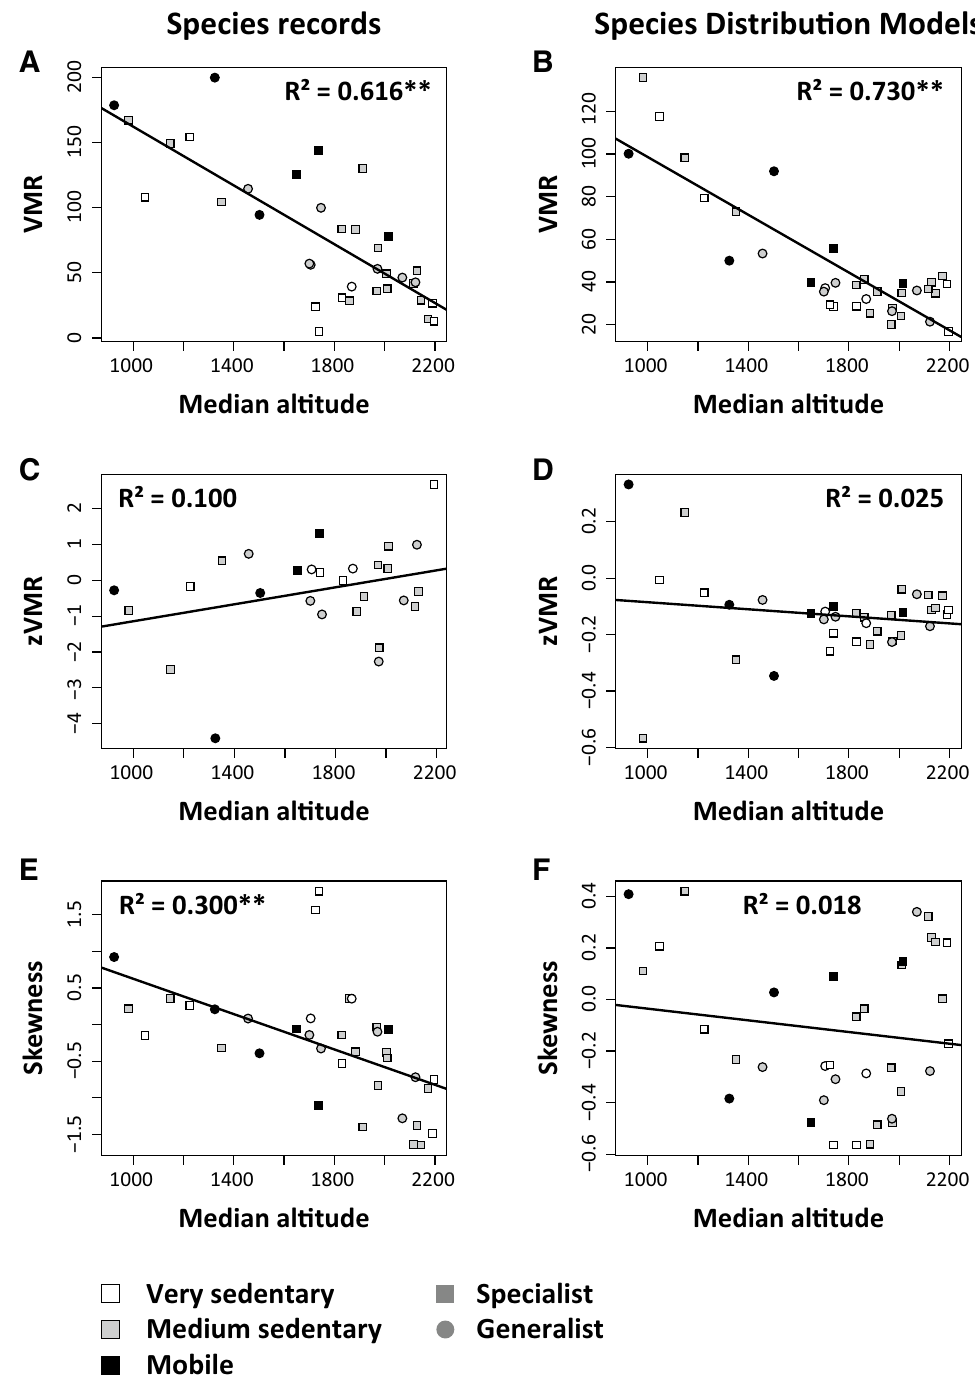
Figure 4. Variance-mean ratios (VMR) of the species altitudinal distribution decreased using both species records and the results from species distribution modelling (SDM) ( A , B ). The slopes of the regressions of annual VMR against study year z VMR increased with increasing altitude using species records ( C ) but not using SDM results ( D ). The skewness of the species altitudinal distributions deceased at higher altitudes using both approaches ( E , F ). R 2 : coefficients of variation of ordinary least squares regression. Parametric significances: ** P <